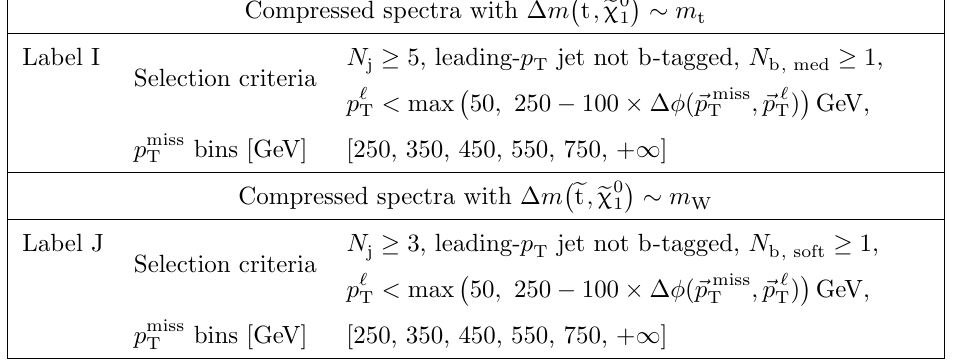
(cid:31) 0 (cid:24) m t ; and (cid:24) m scenarios are labeled with the 1 t W denotes the transverse momentum of the lepton. Each T (cid:0) (cid:1) e e bins column de(cid:12)nes a single signal T